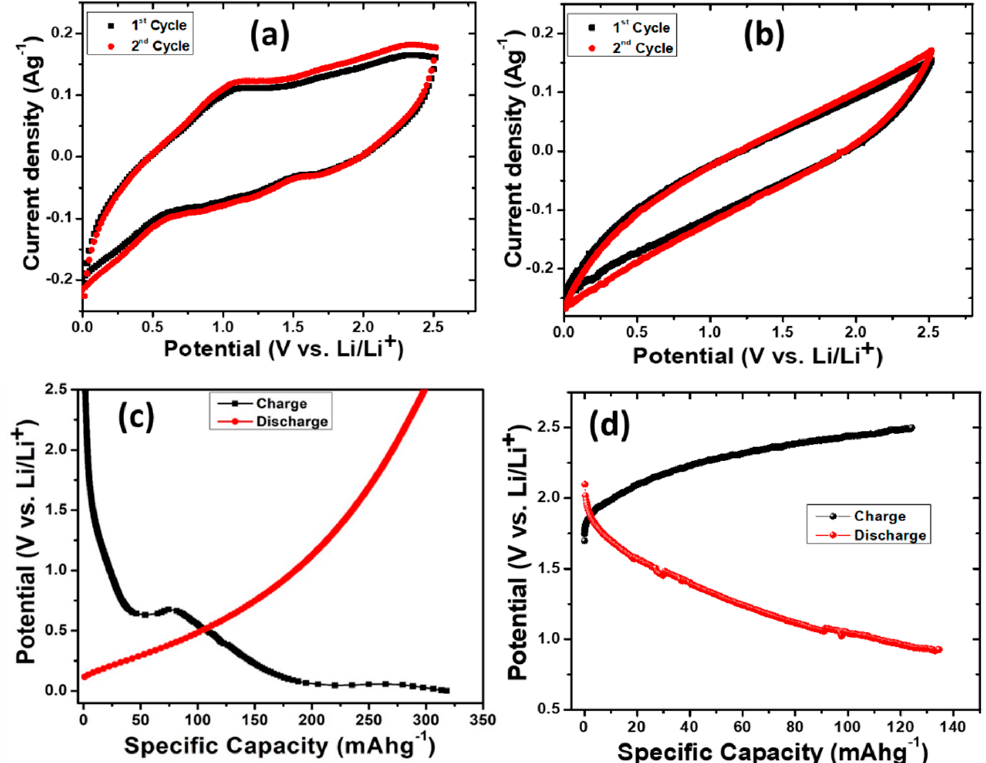
Figure 4. Cyclic voltammograms of ( a ) activated carbon, ( b ) commercial activated carbon at a scan rate of 20 mVs − 1 for the first and second cycle. Galvanostatic charge–discharge curves for the first cycle of fabricated cell with ( c ) activated carbon anode, and ( d ) commercial activated carbon at a current density of 100 mAg − 1 .